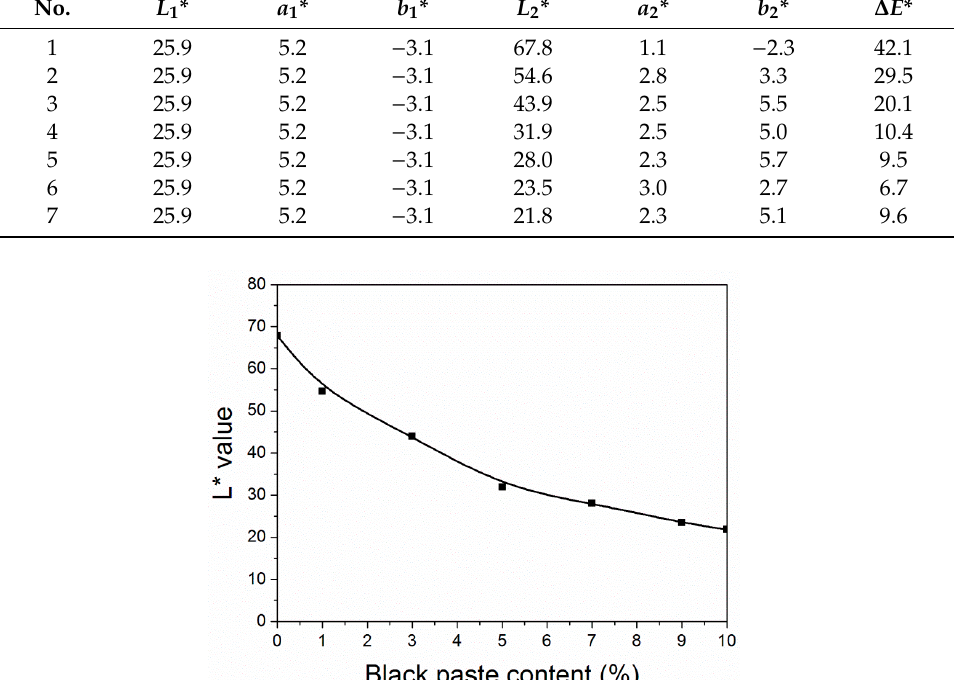
Table 2. Color analysis results with different formulations.